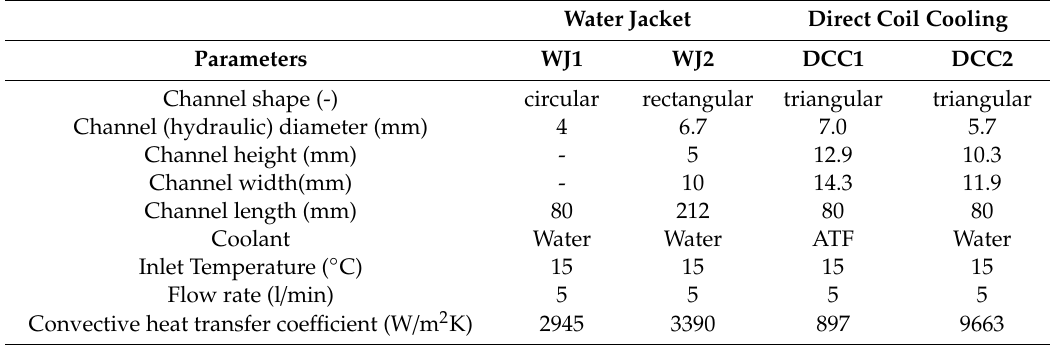
Table 3. Properties of cooling